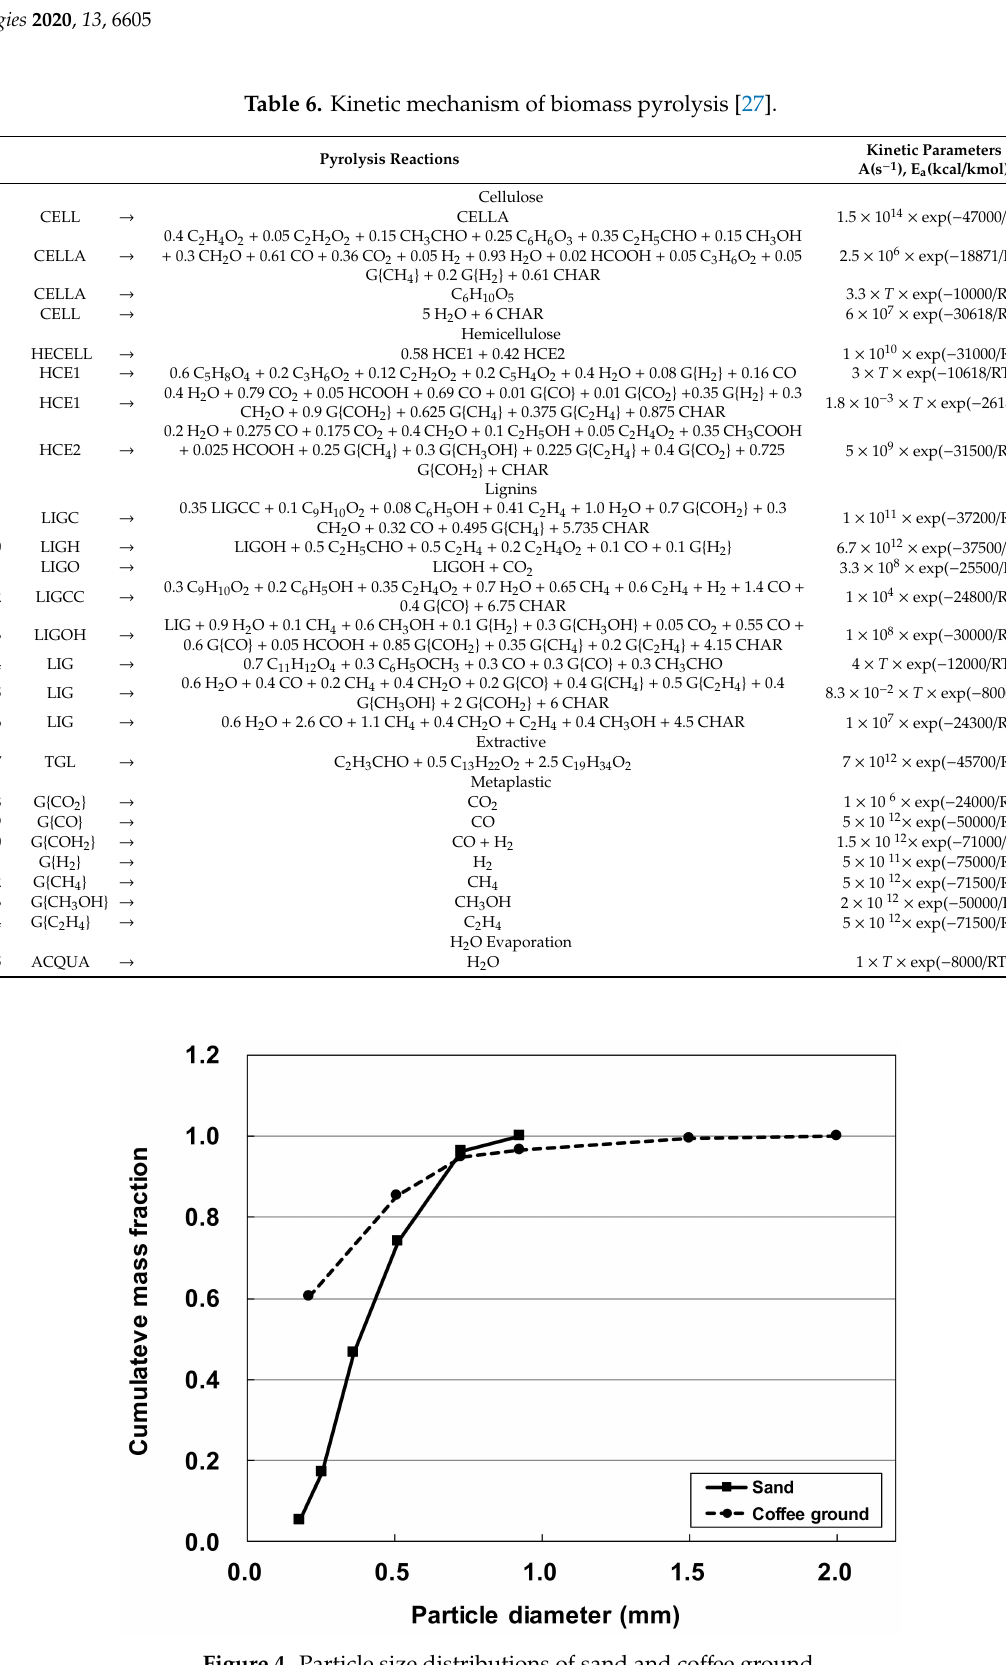
Figure 4. Particle size distributions of sand and co ff ee